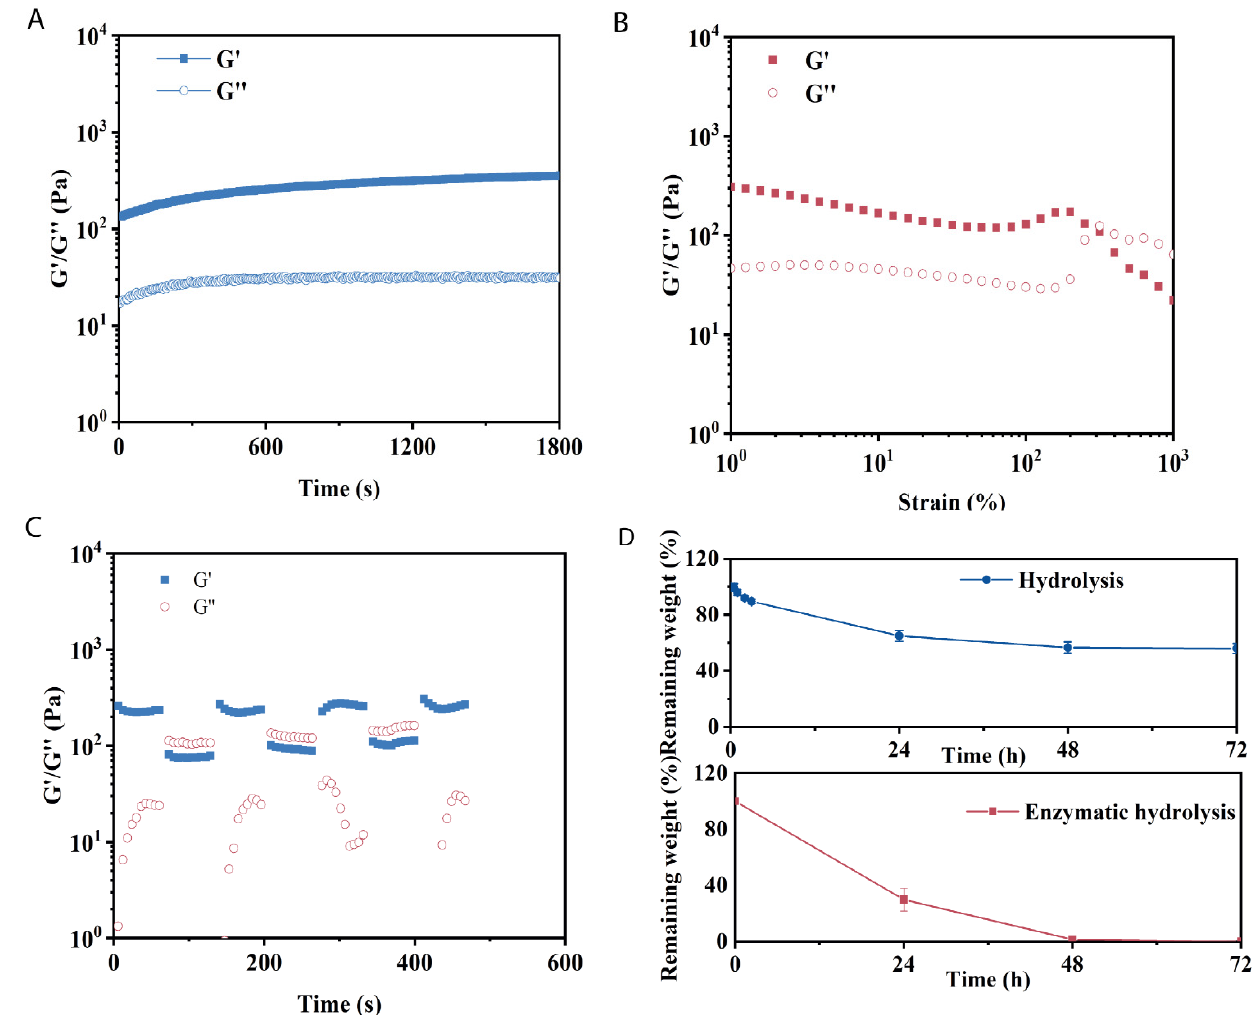
Figure 2. Rheological test and degradation profile of CTS/CTS–CHO hydrogels. ( A ) Time sweep test of the hydrogels (25 °C, 1% strain, and 1 Hz). ( B ) Strain sweep evaluation from 1% to 1000% strain (25 °C and 1 Hz). ( C ) Self-healable properties of the hydrogels evaluated by step-strains between 1% and 500%. ( D ) Degradation profiles of the hydrogels ( n =